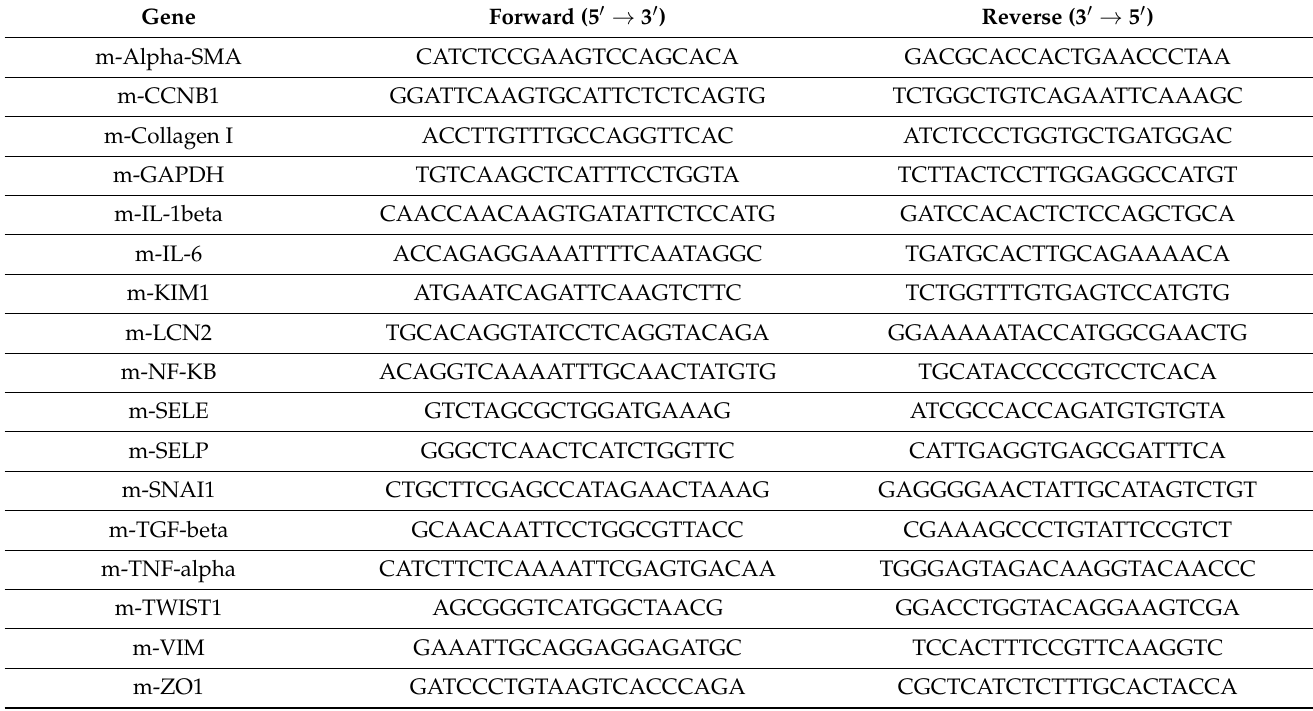
Table 1. Primers used for qRT-PCR to evaluate gene